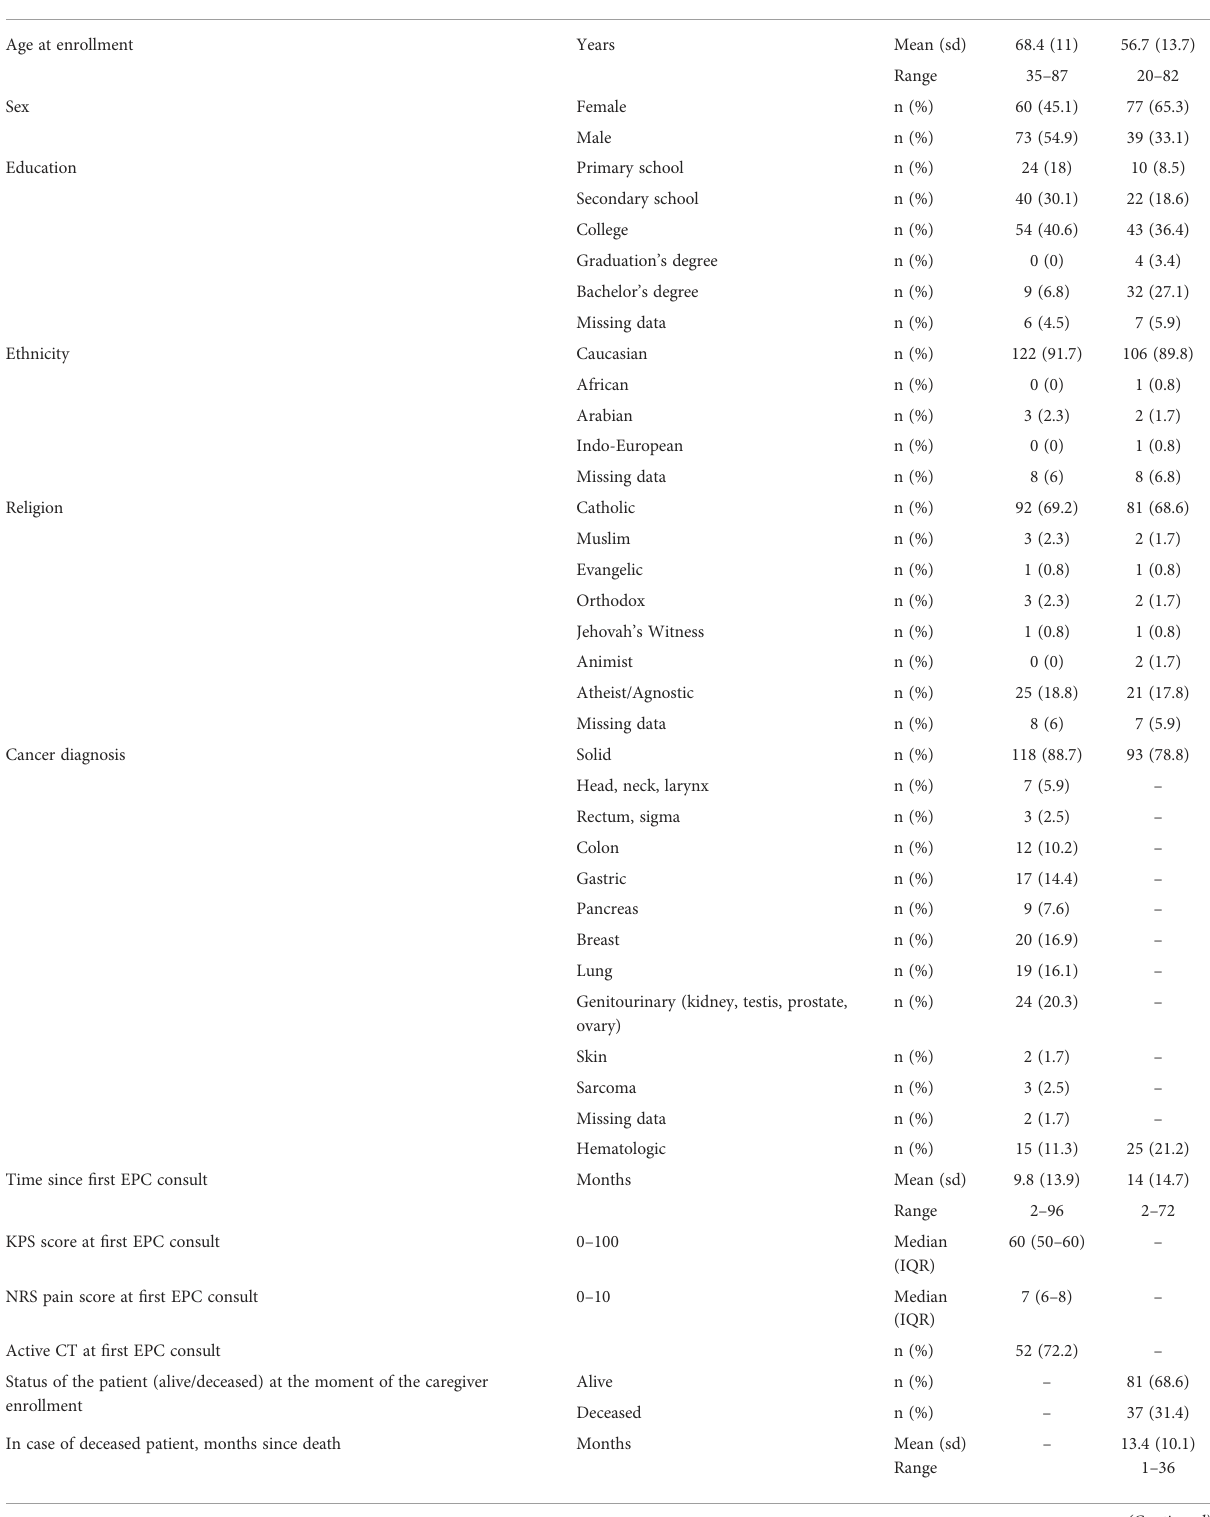
TABLE 2 Demographic and clinical/caregiving characteristics of the sample (n